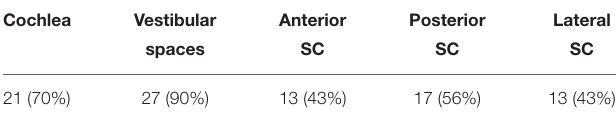
TABLE 7 | Distribution of gadolinium in the perilymphatic spaces expressed in number of patients and percentage.